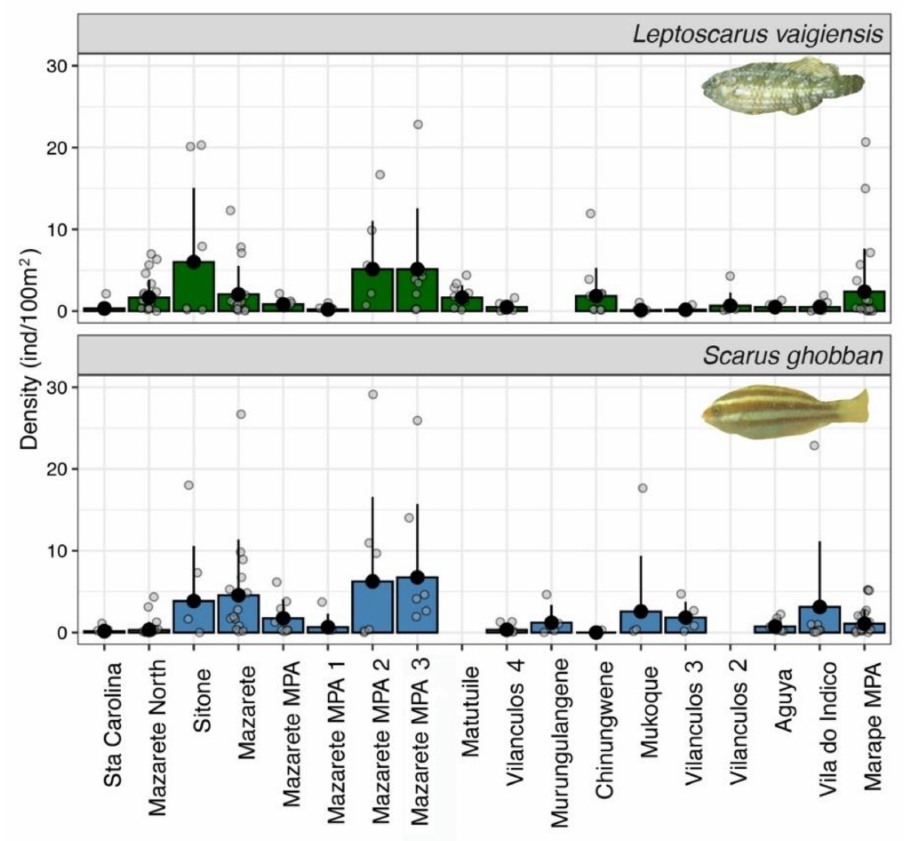
Figure A3. Density L. vaigiensis and S. ghobban in seagrass meadows in the Bazaruto seascape. Seagrass survey sites are ordered by distance to closest